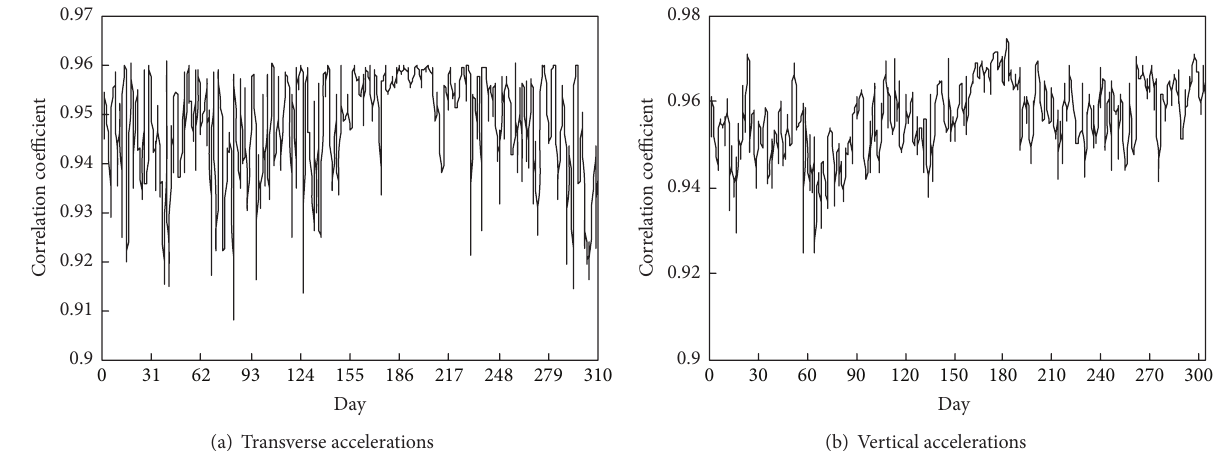
Figure 10: Daily computed correlation coefficients in 2013.